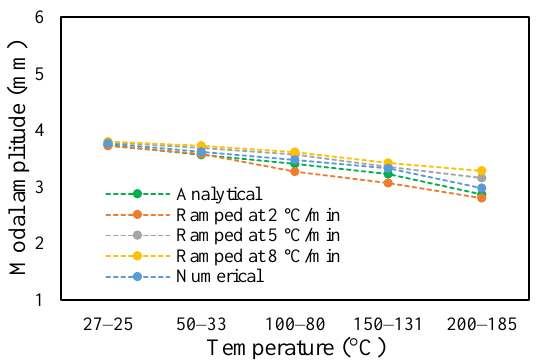
13 of 24 Figure 16. Modal amplitude of 0.25 mm crack depth in non-uniform temperature.